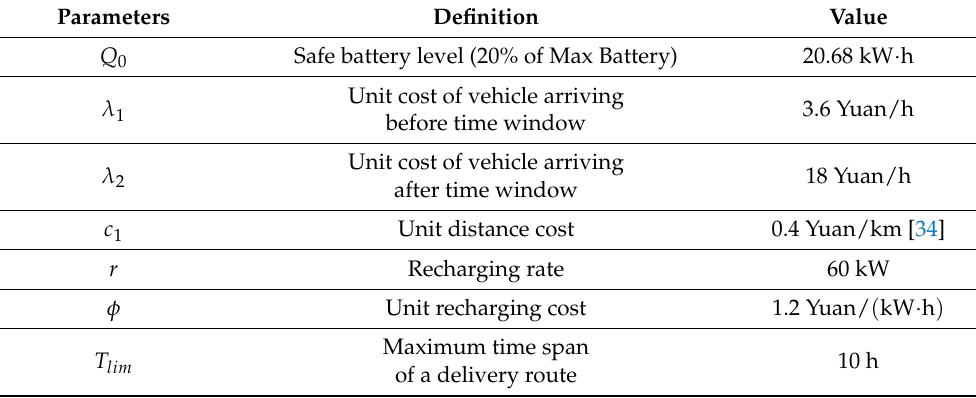
Table 9. Other parameters of EVRPTW-DC.